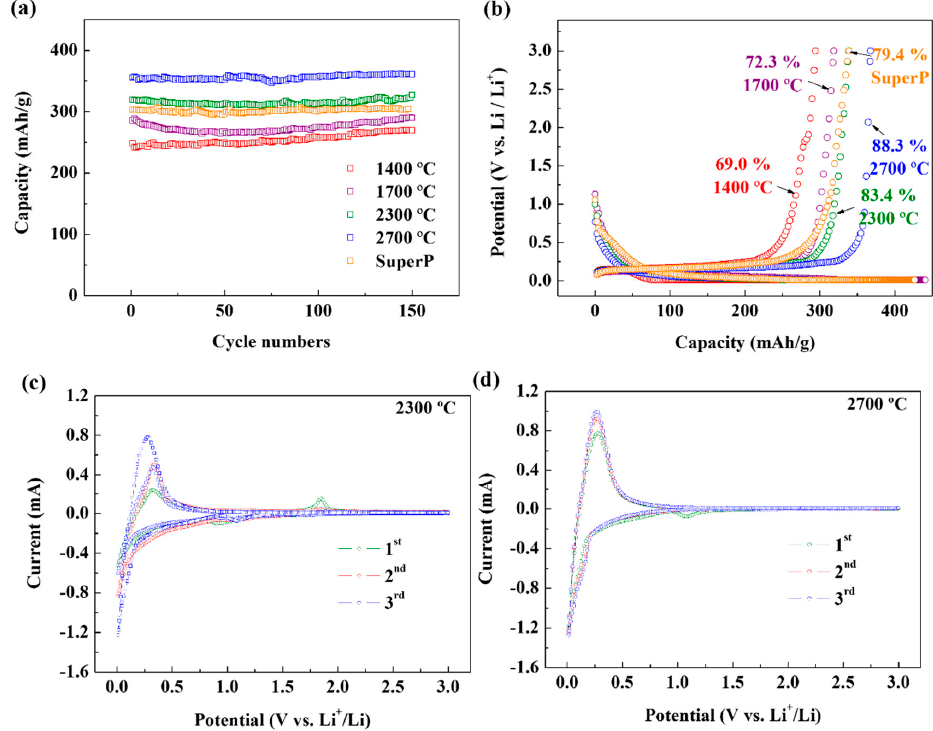
Table 6. Thermogravimetric analysis data of annealed